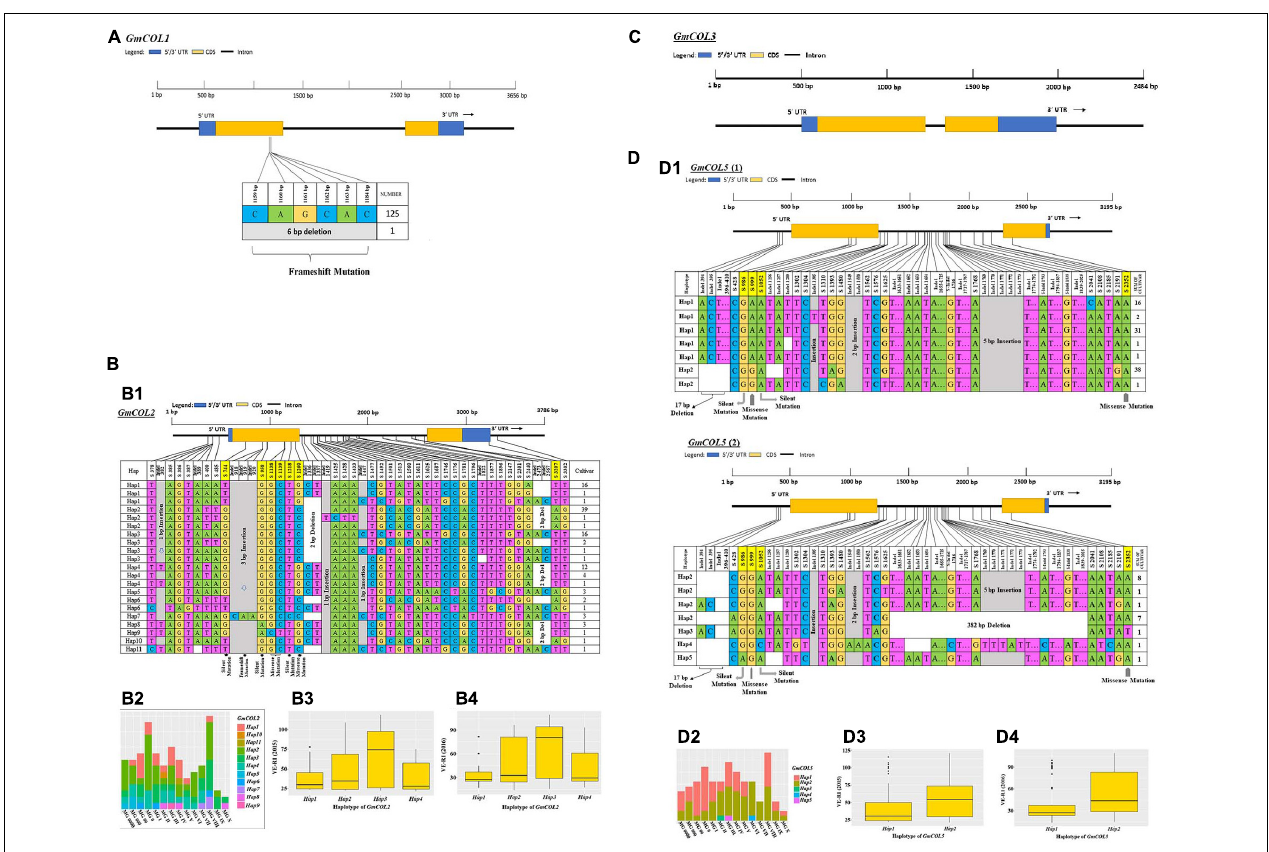
FIGURE 2 | Haplotype analysis, distribution in different maturity groups, and flowering time (VE-R1) in the main haplotypes of approximately four GmCOL family genes. (A) Haplotype of GmCOL1 . (B,B1) Haplotypes of GmCOL2 . The haplotype is shown as a linear combination of alleles. The site combination labeled with the yellow outline represents the tagging haplotype (the composition of the haplotype depends on fewer and critical variation sites). (B2) Haplotype distribution of GmCOL2 in different maturity groups. (B3) Flowering time (VE-R1) of the main haplotypes of GmCOL2 in 2015. (B4) Flowering time (VE-R1) of the main haplotypes of GmCOL2 in 2016. (C) Gene structure of GmCOL3 . (D,D1) Haplotypes of GmCOL5 (1) and GmCOL5 (2). (D2) Haplotype distribution of GmCOL5 in different maturity groups. (D3) Flowering time (VE-R1) of the main haplotypes of GmCOL5 in 2015. (D4) Flowering time (VE-R1) of the main haplotypes of GmCOL5 in